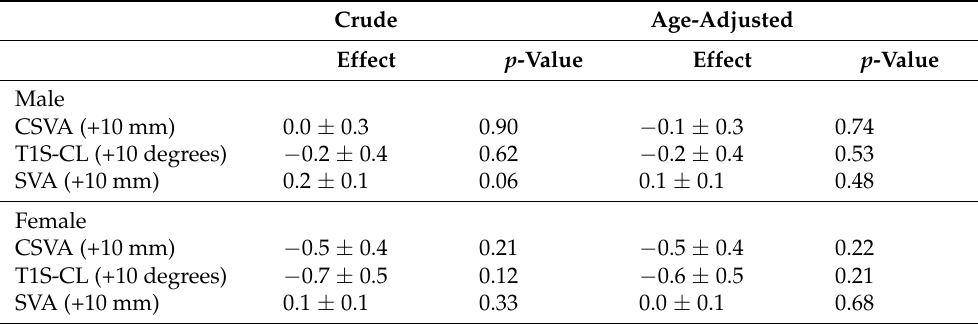
Table 5. Effects of cervical alignment parameters on SF-8 TM mental component summary